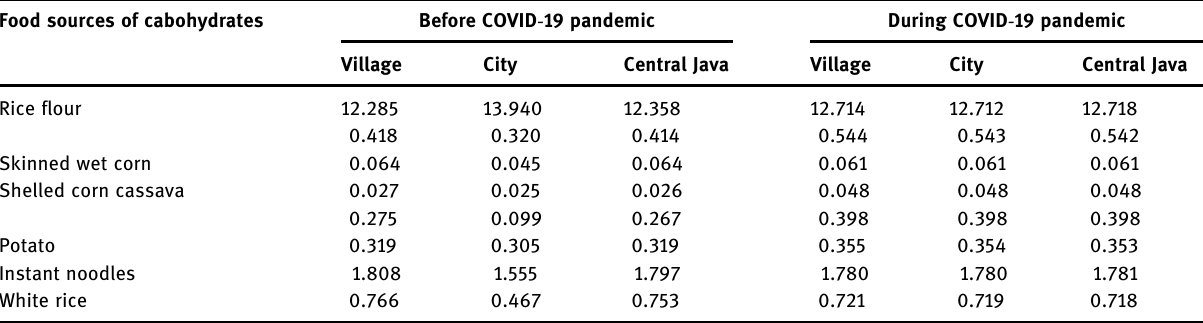
Table 1: Share of expenditure on carbohydrate - sourced food by area of residence in Central Java before and during the COVID - 19 pandemic Food sources of